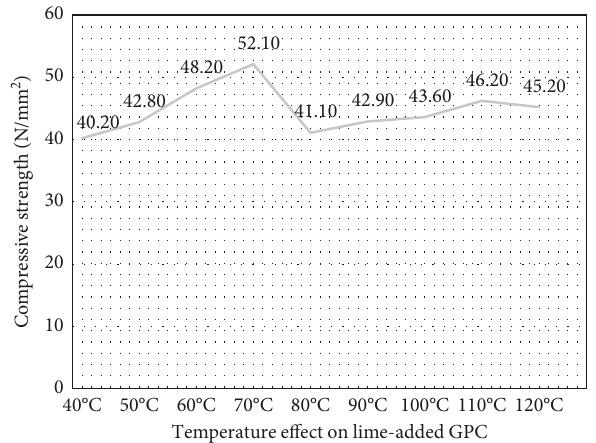
Figure 3: Cube cured at natural room temperature. Figure